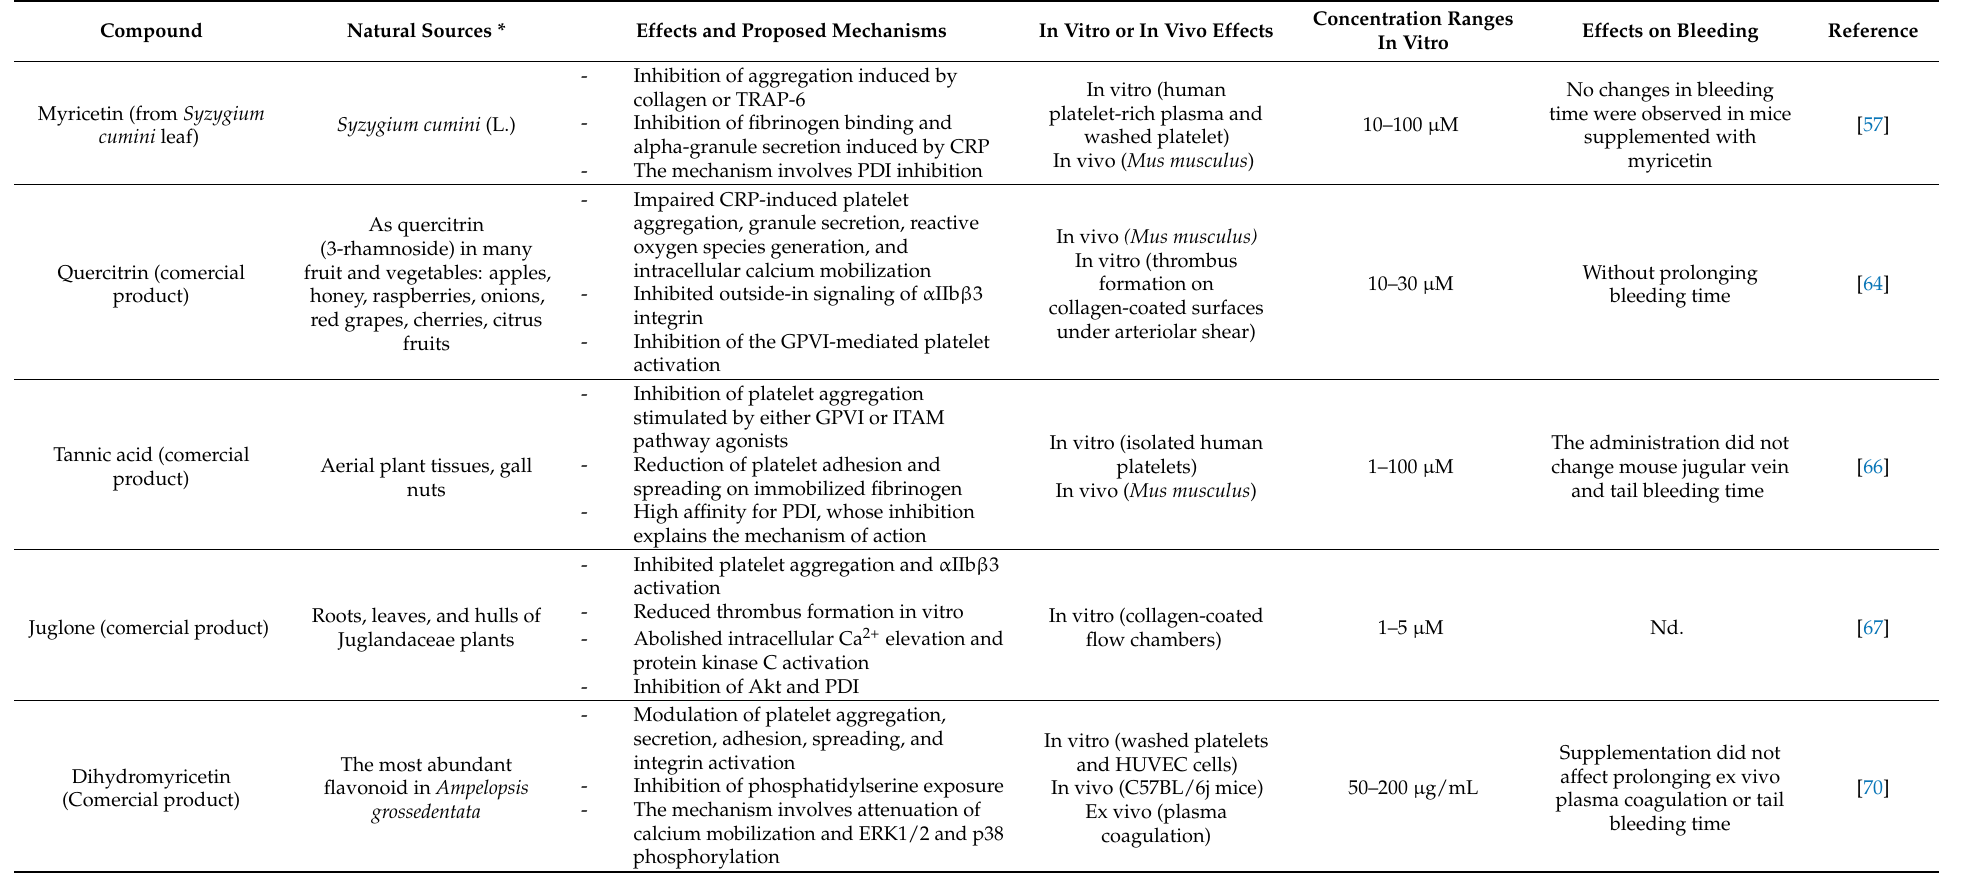
Table 1. Antiplatelet compounds without increasing bleeding